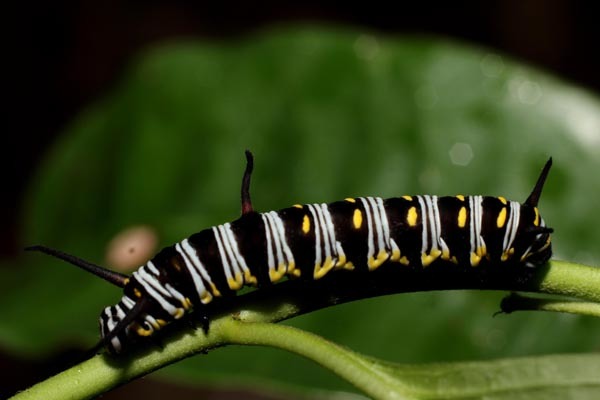
Danaus
gilippusDHJ02 voucher n. 13-SRNP-10060, feeding on Asclepiadaceae. Image voucher n. DHJ498910.jpg